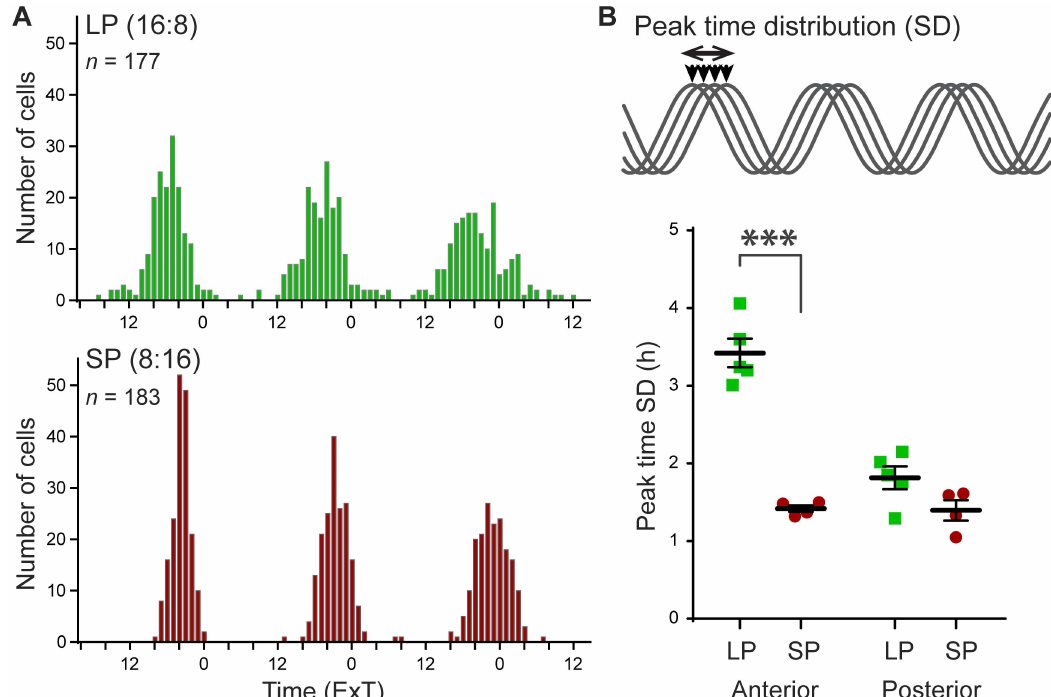
Fig 2. Exposure to long photoperiod increasespeak time distribution. (A) Representative histograms of peak times of two individual slices from the anterior SCN in long (LP, n = 177 cells) and short photoperiod(SP, n = 183 cells) plotted in external time (ExT). (B) Phase distributionis definedas the standarddeviation(SD) of peak time, of the first cycle in vitro (top panel). Phase distributionwas calculatedper slice, and is shown for the anterior and posterior SCN (bottom panel), in LP (green squares)and SP (red circles). Black bars indicatemean ± SEM; *** p < 0.001.